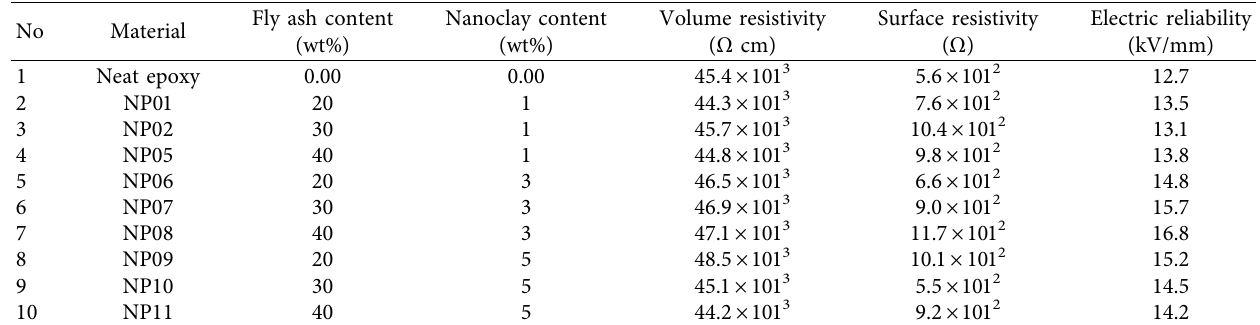
Figure 7: XRD of materials: nanoclay (I.30 E), epoxy/nanoclay, and epoxy/nanoclay/fly ash (NP08). Table 10: Dielectric properties, and reliability strengths, and surface resistivity of epoxy